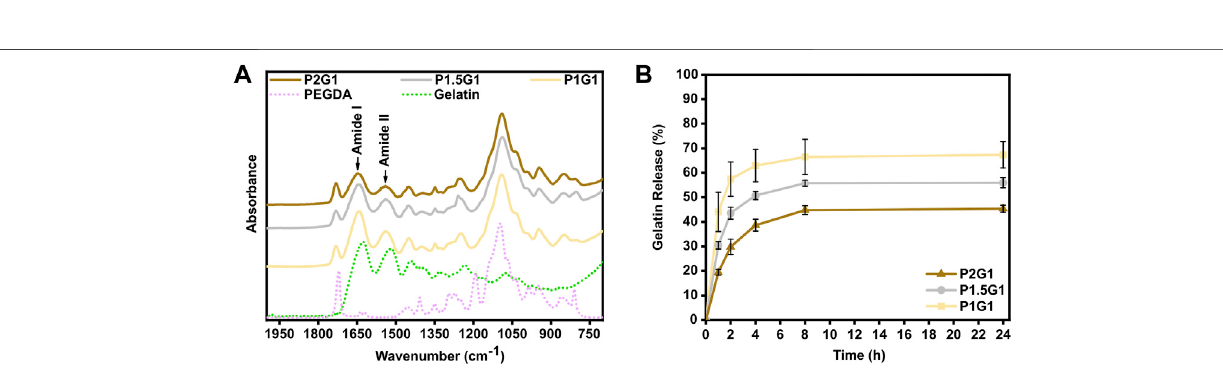
FIGURE 2 | Evaluation of chemical cross-linking of gelatin within hydrogels. (A) Attenuated total re fl ectance-infrared spectroscopy (ATR-FTIR) spectra of pristine hydrogel samples, gelatin powder and non-crosslinked PEGDA in the 2000 – 700 cm − 1 wavenumber range. (B) Cumulative gelatin release (wt%) from pristine hydrogels at 1, 2, 4, 8 and 24 h in DIH 2 O at 37 ° C. Percentages are referred to the total amount of gelatin within the